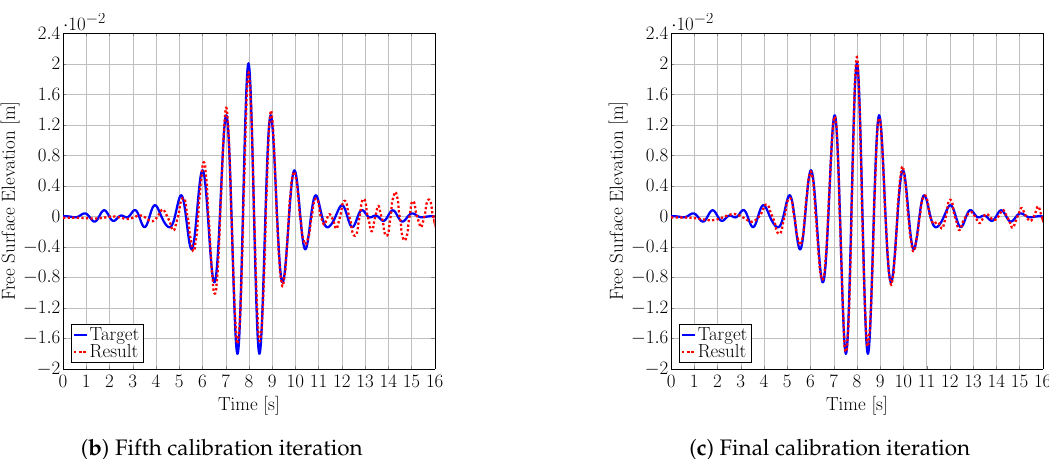
Figure 5. Example of the target and resulting surface elevation, at different calibration iterations, for the same case as Figure 4.